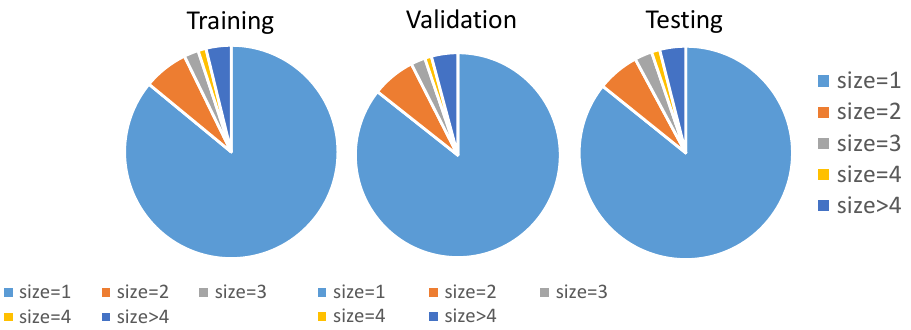
Figure 7. The distribution of labels (i.e., cascade